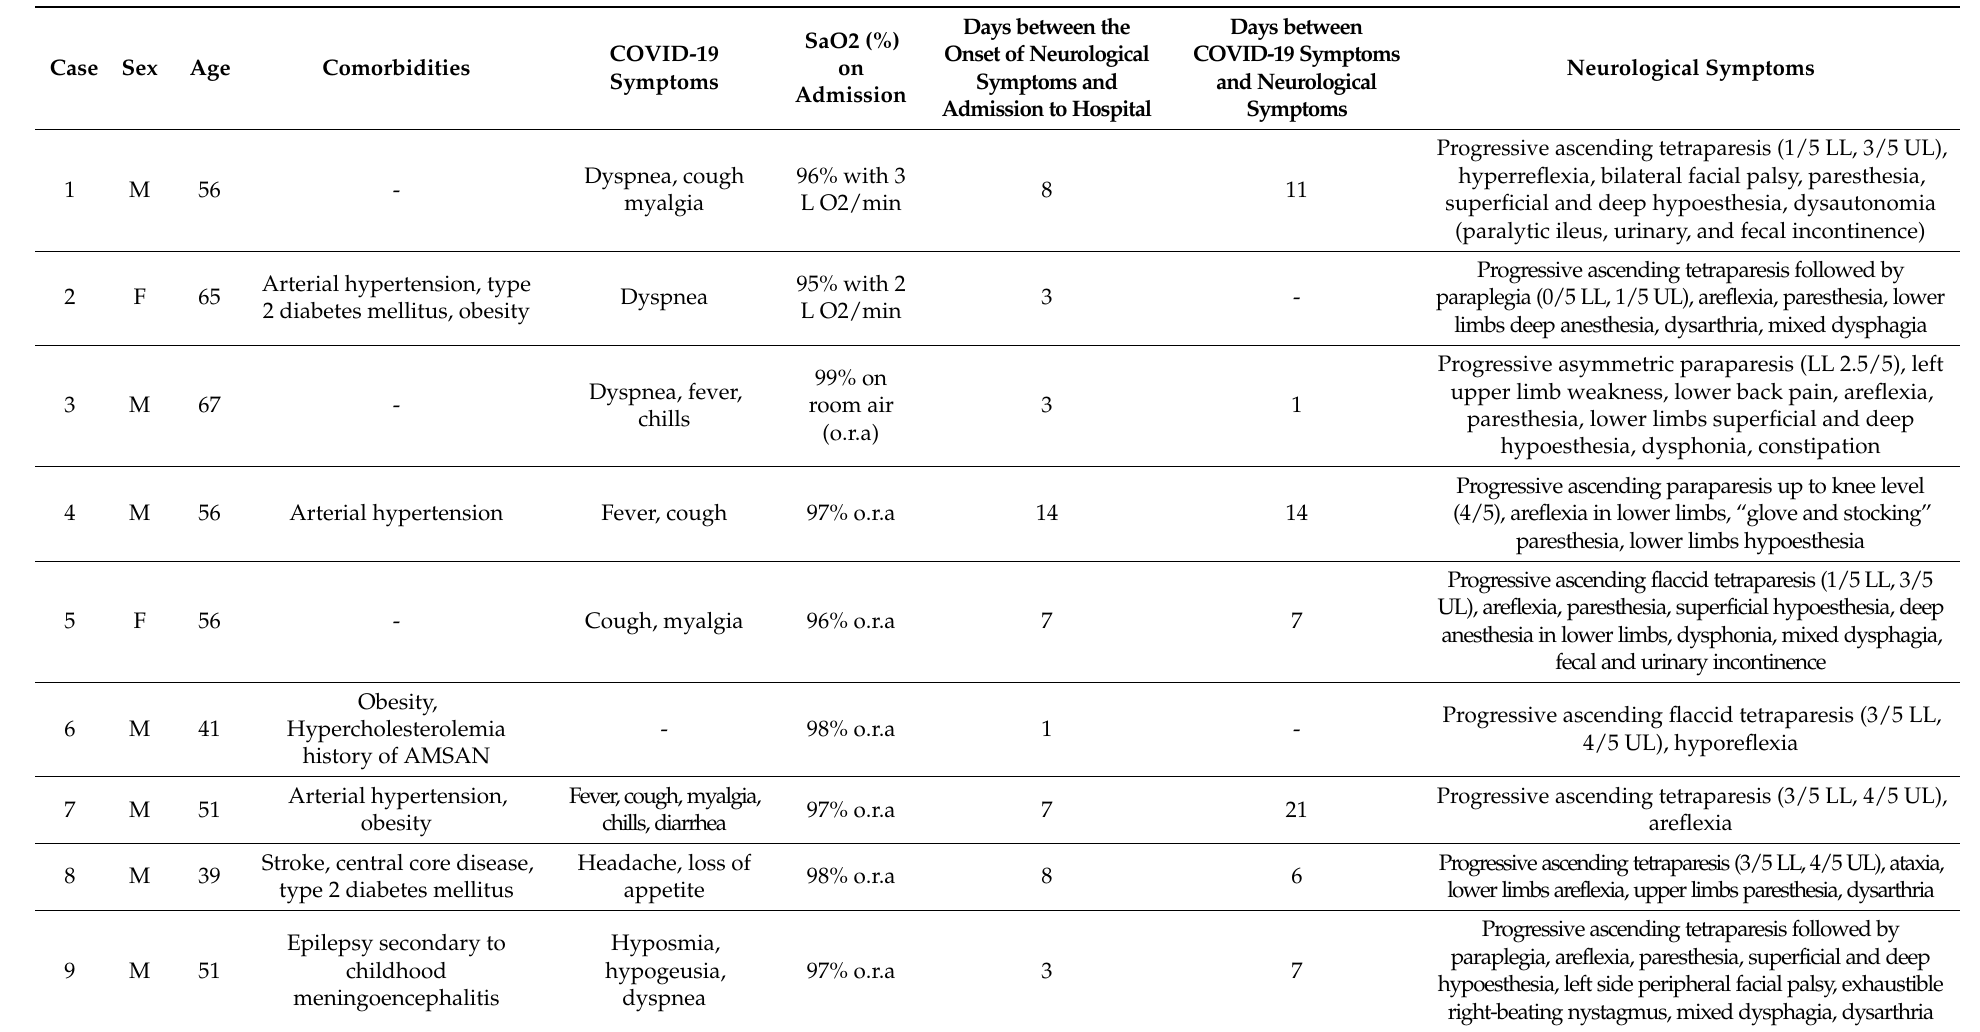
Table 1. Patient clinical